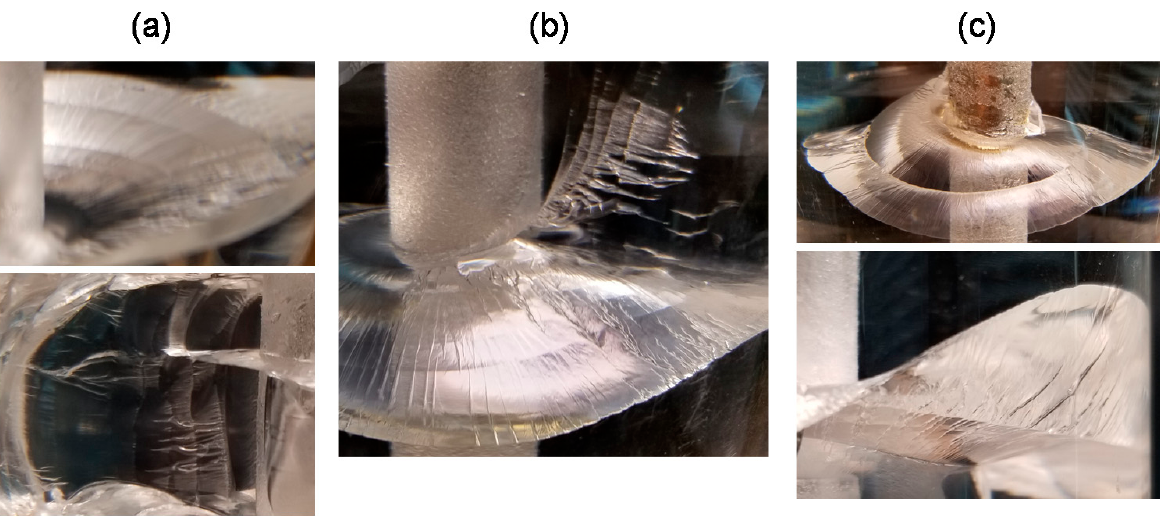
Figure 9. Striations in the cryogenic fractures in PMMA. Striations in horizontal and vertical fractures in ( a ) Specimen 1 and ( b ) Specimen 2. ( c ) Examples of distinct changes in curvatures at striations in Specimen 1.